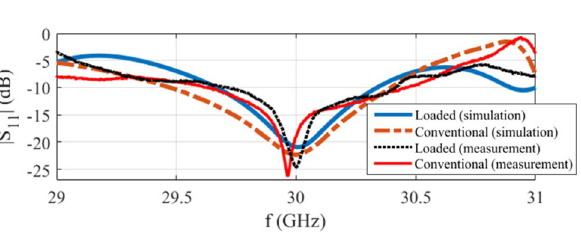
Figure 6. The simulated and measured |S 11 | of the conventional and loaded